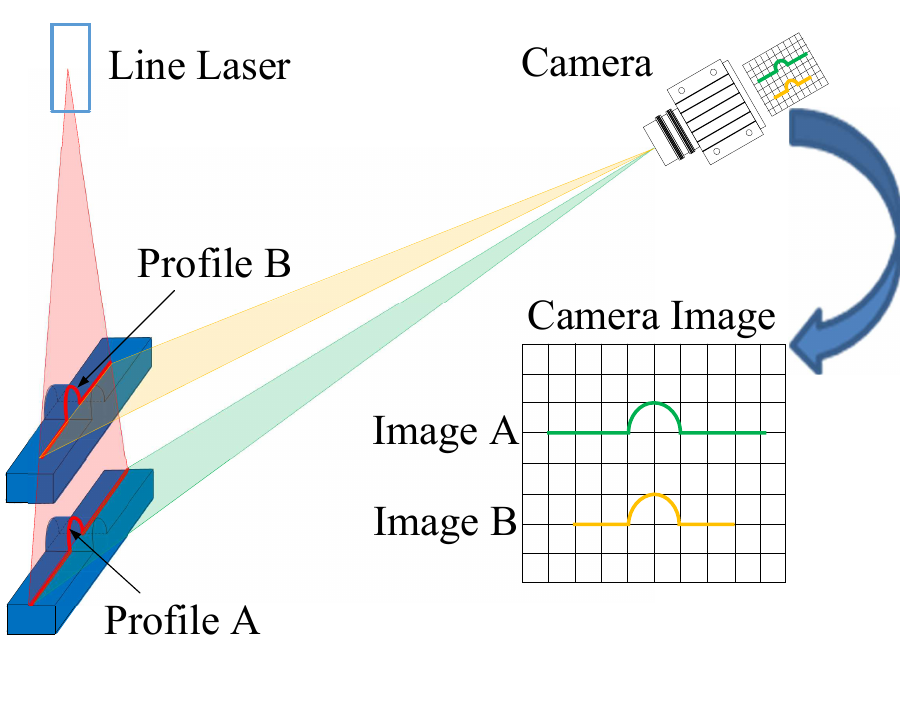
Figure 1. System